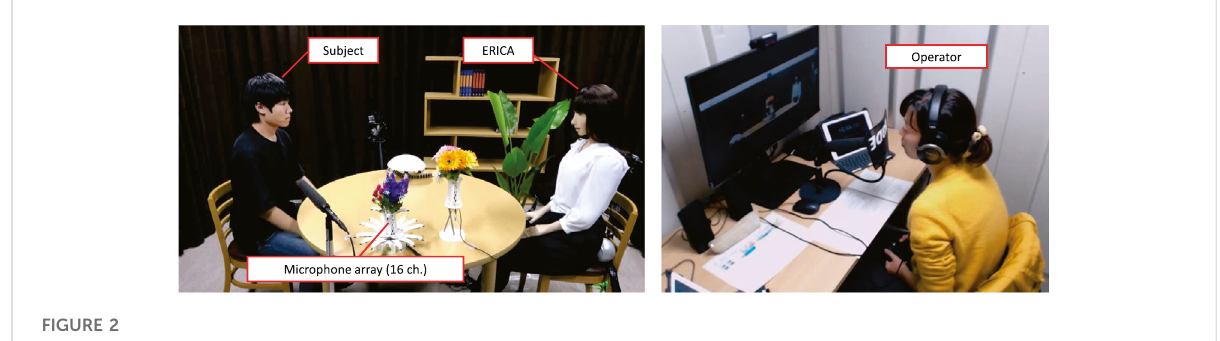
FIGURE 2 Snapshot of dialogue recording.